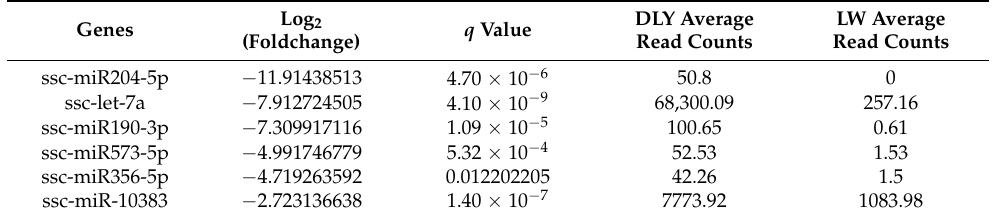
Table 6. The downregulated miRNAs in the Longissimus dorsi muscle sample of LW pigs. Genes